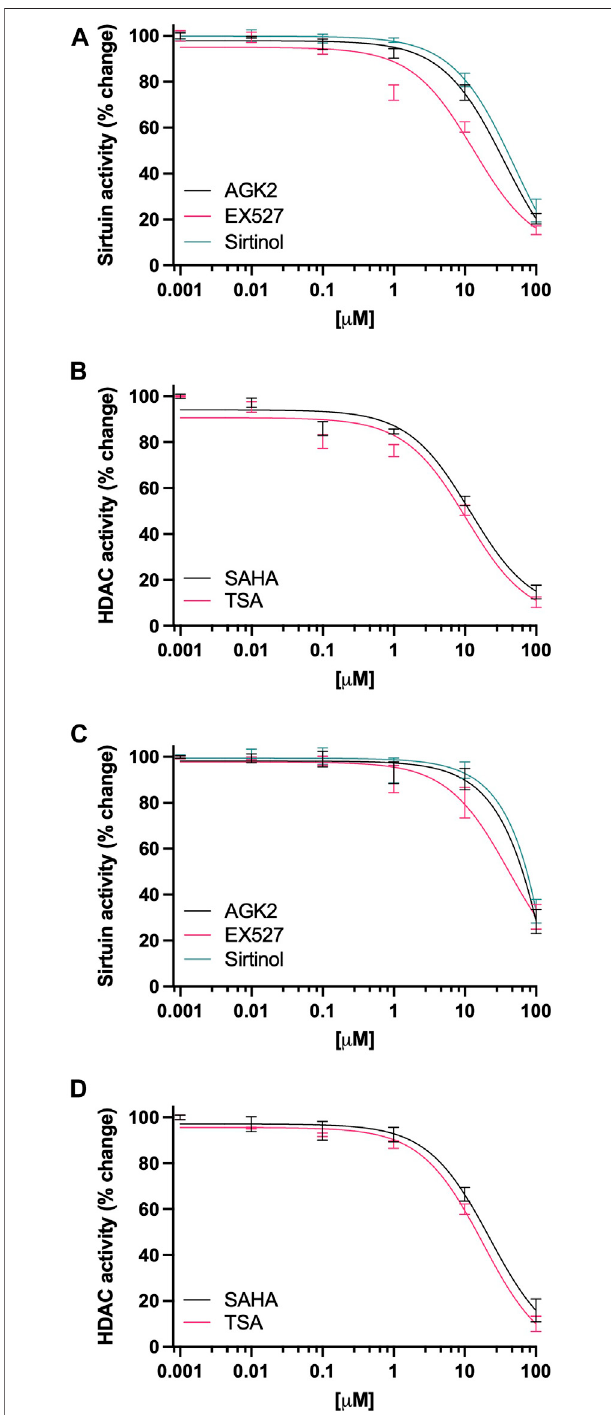
FIGURE 1 | Inhibition of Sirtuin and HDAC activity in breast cancer cell lines. (A, C) Quanti fi cation of the catalytic activity of Sirtuin in ZR-75-1 and MDA-MB-231 cells, respectively, after 48-h treatment, cells were treated with 0 – 100 µM of AGK2 (black line), EX527 (pink line) or Sirtinol (green line). (B, D) Quanti fi cation of the catalytic activity of HDAC in ZR-75-1 and MDA- MB-231 cells, respectively, after 48-h treatment, cells were treated with 0 – 100 µM of SAHA (black line) or TSA (pink line). Data is presented as the mean ± SEM of four independent